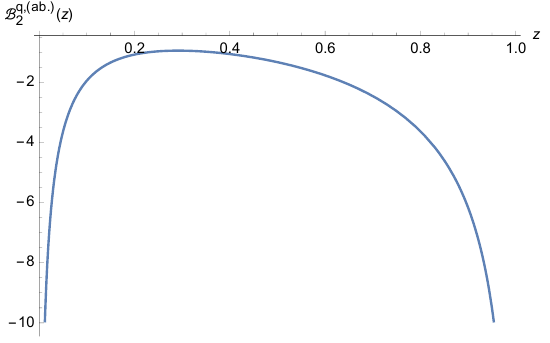
Figure 5 . Figure showing the dependence of B q, (ab.)